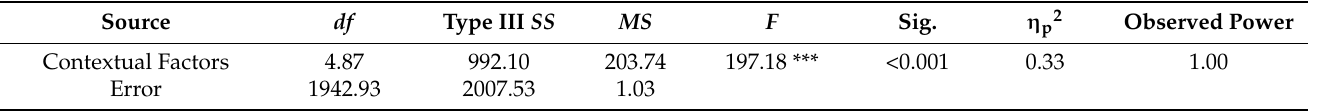
Table 7. Within-subjects effects of Contextual Factors on